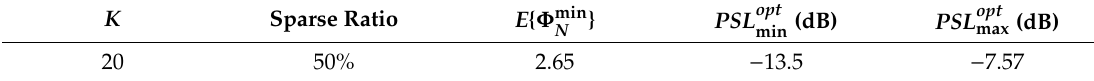
Table 1. All Peak Side Lobe Levels ( PSLL s) for the arrays thinned by ADS.